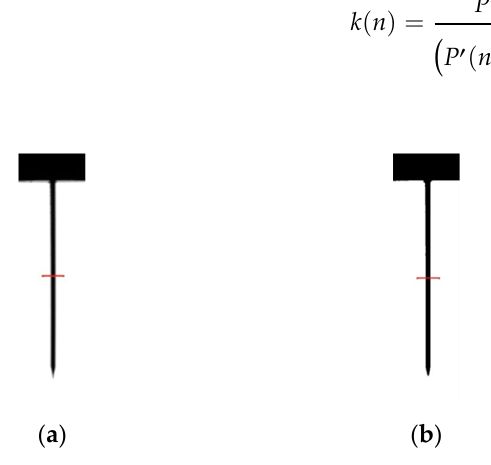
Figure 4. ( a ) ROI of the acquired image; ( b ) ROI of the Otsu method-based binary image; ( c ) comparison of the gray values of two images along same line profile.